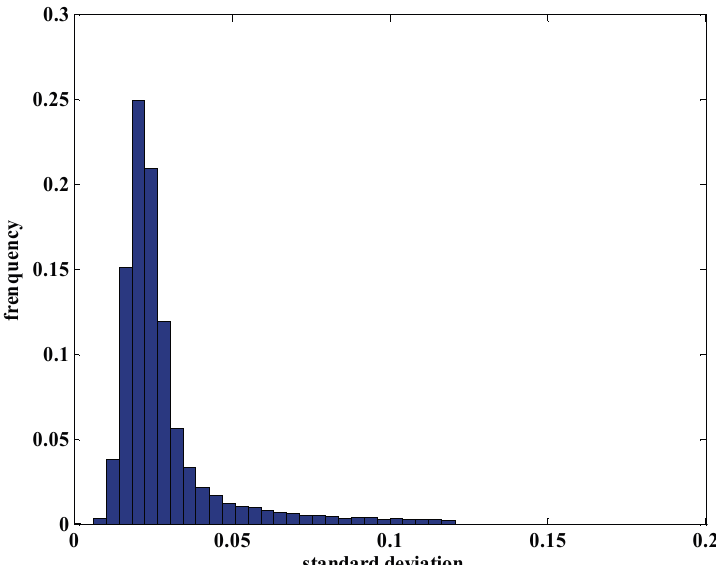
Figure 2. Distribution of hourly standard deviations of CO Zhongshan Station for the period of